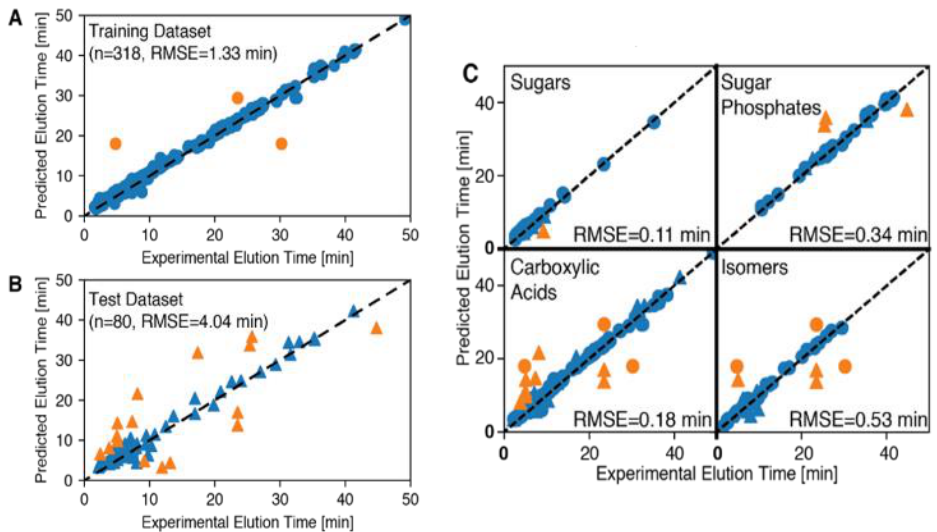
Figure 3. Model performance: ( A ) The performance of the trained MPNN on the training dataset (with 318 data points). Blue points represent data for which the model error is <2 min and orange points represent data where the model error ≥2 min. The dashed black line represents line of zero error. The model RMSE on the training dataset is 1.33 min. ( B ) The performance of the trained MPNN on the held-out test dataset (with 80 data points). The RMSE on this test dataset is 4.04 min. ( C ) The model performance on four different sets of compounds: sugars, sugar phosphates, carboxylic acids, and isomers. Circles represent points that the MPNN model was trained on. Triangles represent points from the held-out test dataset.